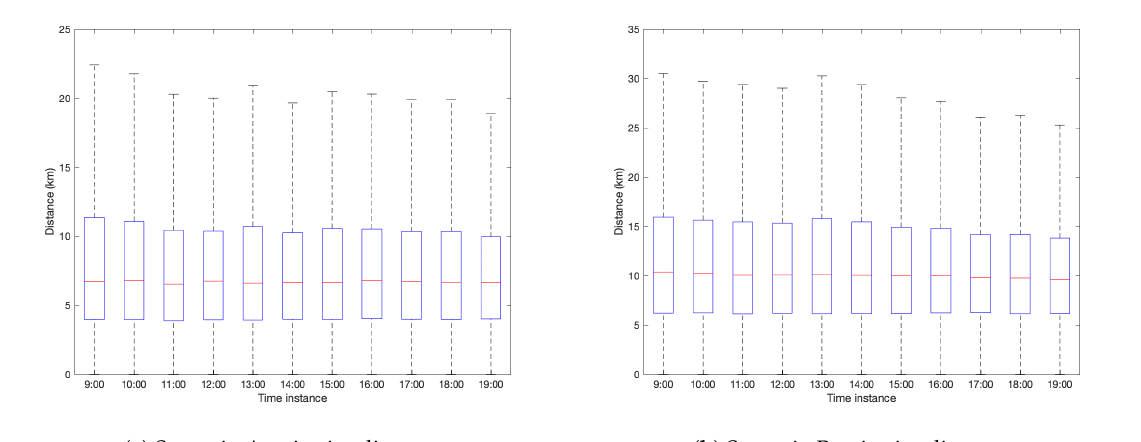
Figure 3. Distribution of pairwise distance of all customer locations. Left: Scenario A; Right: Scenario B.